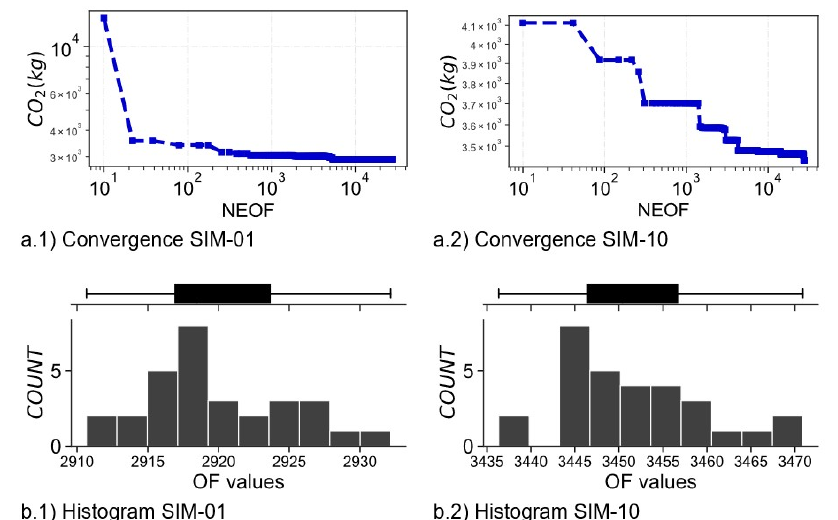
Figure 6. Result of the optimization process a) Convergence kg vs . Number of Evaluations of the Objective Function (NEOF); b) Histogram of the 30 repetition runs.